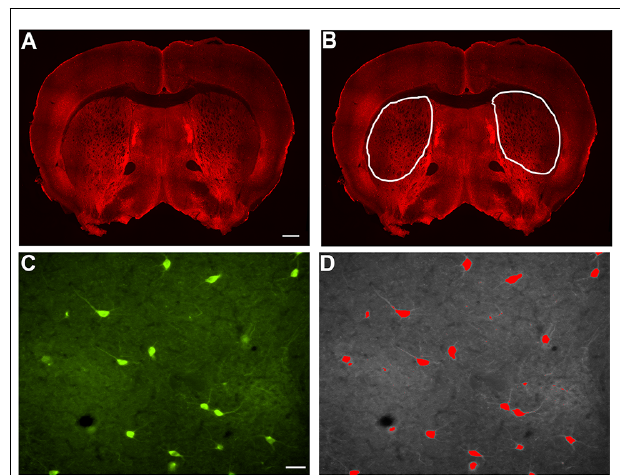
FIGURE 1 | Example of indirect immunofluorescence and thresholding of image. (A) A stitched image of indirect immunofluorescent staining of SOM+ interneurons in a coronal section containing rostral striatal tissue. In order to count the positively stained interneurons, a region of interest was drawn around each striatal half (B) , and the number of cells per half were counted and analyzed as number/1 × 10 6 µ m 2 striatal area in Figures 2C , 3C , 4C , and 5C . Indirect immunofluorescent staining of ChAT+ cells in a 20 × image is shown (C) . The thresholding method was utilized to identify only the cell bodies above the threshold, while excluding the processes, in each 20 × image (D) . Only cell bodies with processes within the same focal plane were analyzed in Image J Fiji. The average area of all of the cells in a single 20 × image is represented as a single data point in Figures 2D , 3D , 4D , and 5D . Similarly, the average perimeter of all the cells in a single 20 × image is represented as a single data point in Figures 2E , 3E , 4E , and 5E . The total number of cells analyzed for each interneuron type are represented in the results. Scale bar = 500 µ m in (A) and scale bar = 100 µ m in (C)